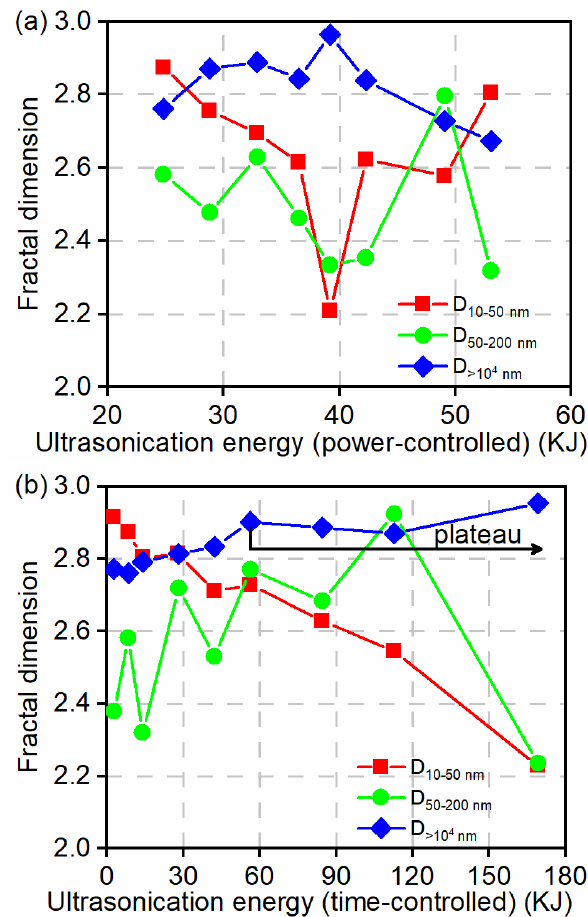
Figure 4: Effect of ultrasonication energy on the fractal dimen- sions of GO/MWCNT-OPC pastes: (a) power-controlled, (b) time-